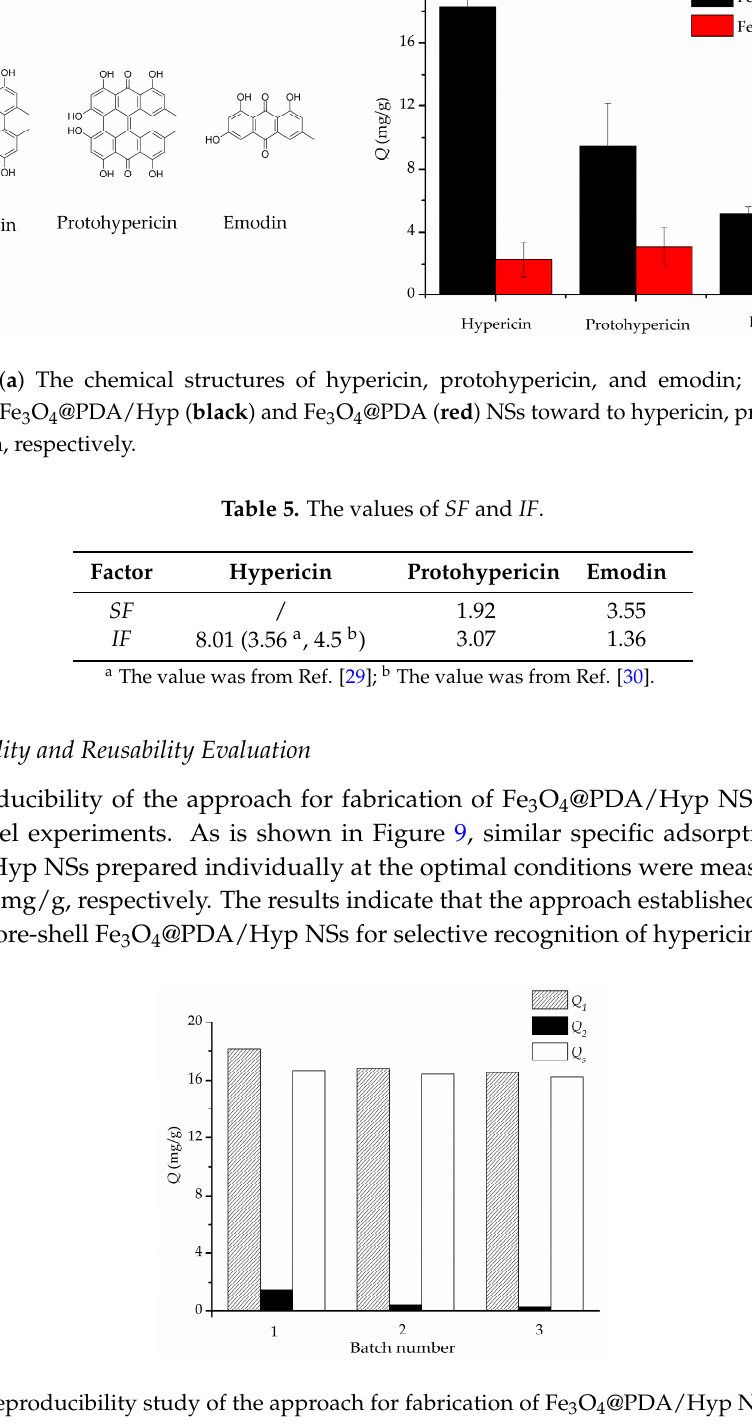
Figure 9. Reproducibility study of the approach for fabrication of Fe 3 O 4 @PDA/Hyp NSs under the optimized conditions.